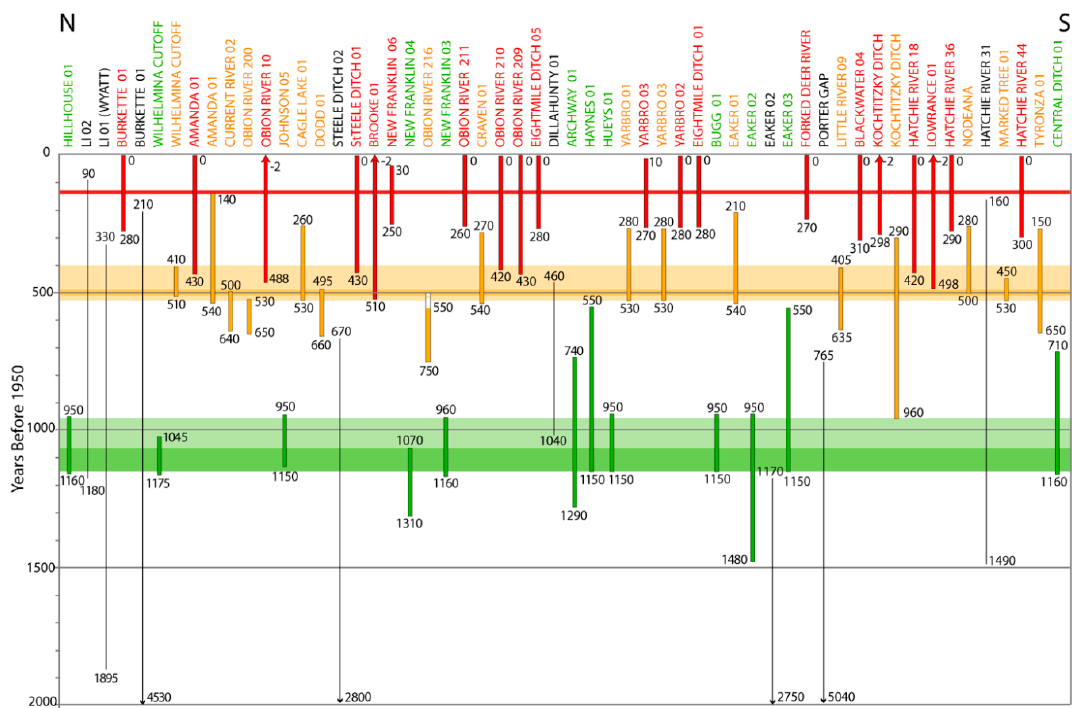
Figure 18. Earthquake chronology of the New Madrid seismic zone for the past 2000 years based on paleoliquefaction studies (e.g., References [6,7,51]). Vertical bars represent age estimates of individual sand blows, and horizontal bars represent inferred event times based on intersection of overlapping age estimates: 138 years before present (BP) (AD 1811–1812); 500 years BP (AD 1450) ± 150 years; 1050 years BP (AD 900) ± 100 years. Statistical analysis resolved event times with narrower uncertainty ranges of 503 years BP ± 8 years and 1110 years BP ± 40 years as indicated by darker portions of the horizontal bars [35].